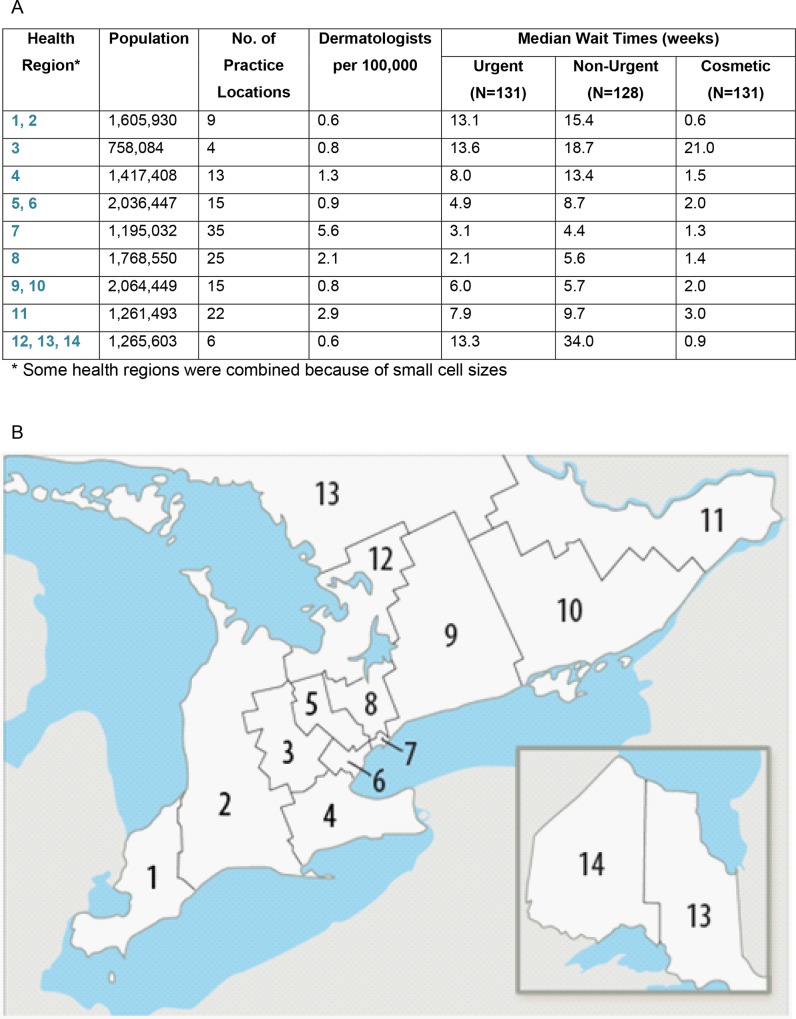
(A) Median Wait times by physician demographics and regional health authority* [16] (B) Map of regional health authorities produced by Ontario Local Health Integration Networks [17].